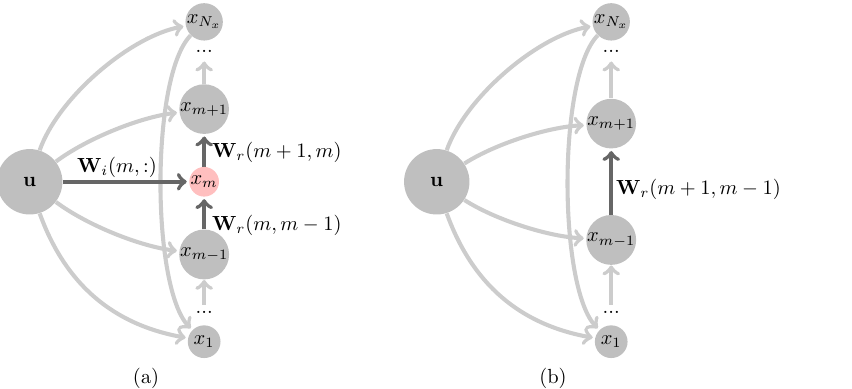
Figure 3. Weight coefficient diagram of connections of neurons in the reservoir of SCRN before ( a ) and after ( b ) pruning a neuron by